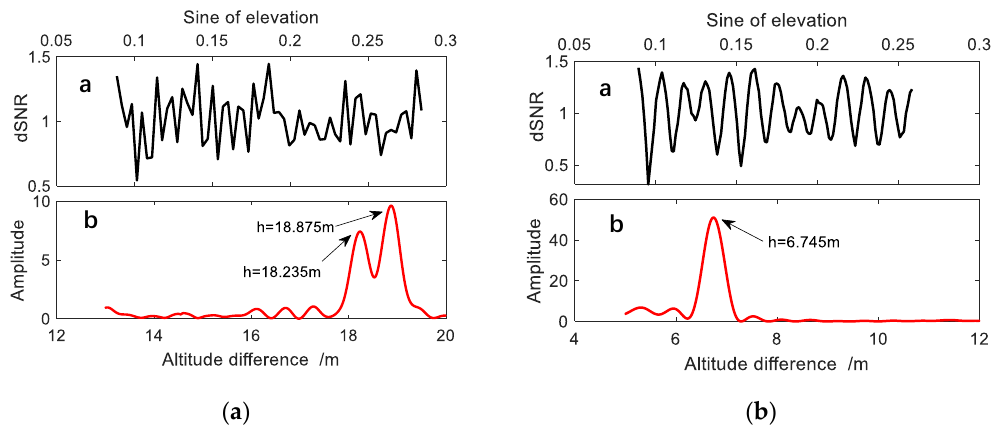
Figure 4. ( a ) dSNR and spectrum analysis results of single SNR sequence at BRST station; ( b ) dSNR and spectrum analysis results of reservoir station.